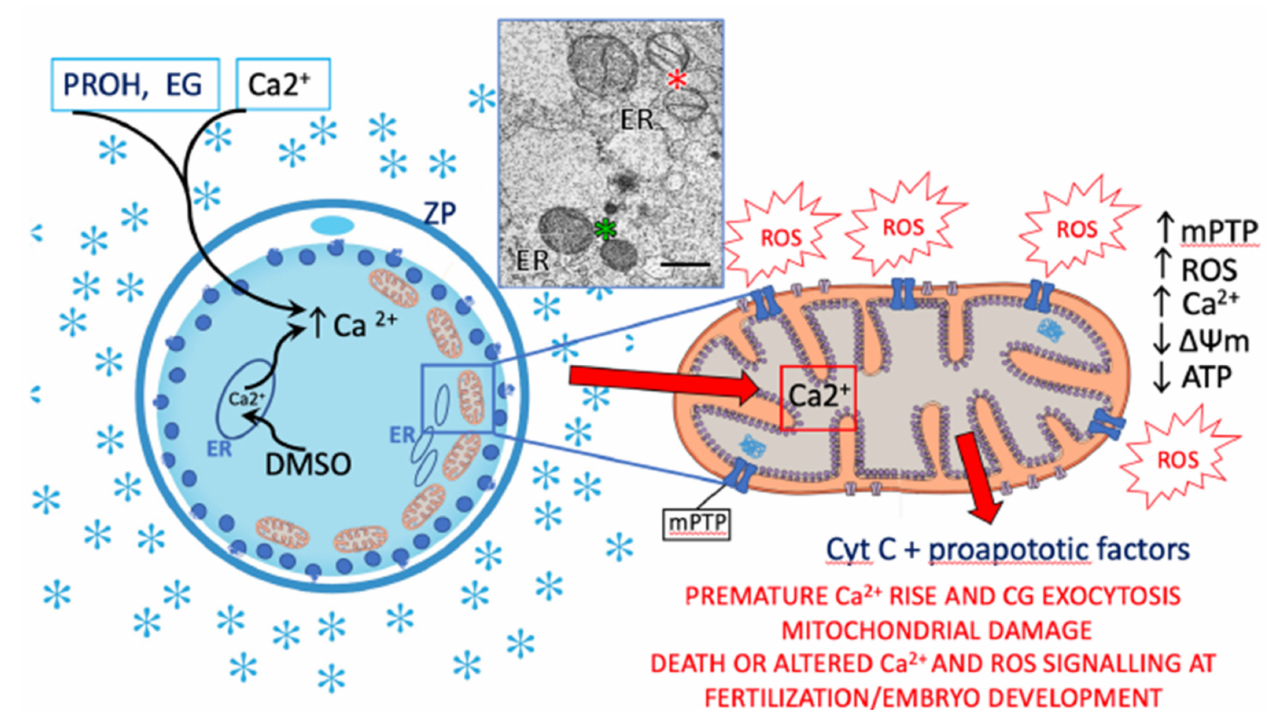
Figure 4. Possible mechanisms of oocyte mitochondrial disfunctions associated with cryopreservation. Exposure to permeant cryoprotectants causes intracellular Ca 2+ increase. Propanediol (PROH) and ethylene glycol (EG) vehiculate external Ca 2+ , whereas dimethyl sulfoxide (DMSO) triggers Ca 2+ release from the endoplasmic reticulum (ER). Premature Ca 2+ rise causes partial cortical granule (CG) exocytosis and zona pellucida (ZP) hardening. Prolonged openings of mPTP due to Ca 2+ overload trigger ROS and Ca 2+ release, loss of ∆Ψ m, decreased ATP content, and release of Cyt C. Such events may culminate in DNA damage and apoptosis. The extent of mitochondrial injury in cryopreserved oocytes determines whether the oocyte dies or survives. Substantial mitochondrial damage might lead to altered Ca 2+ and ROS signaling at fertilization, and compromised embryo development. Inset, intact (green asterisk) and damaged (red asterisk) mitochondria in a human oocyte cryopreserved through slow cooling (bar = 0.5 µ